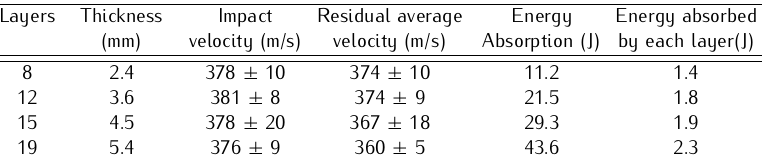
Table 2. Initial and residual velocities for laminates of 0/90 lay-up sequence.